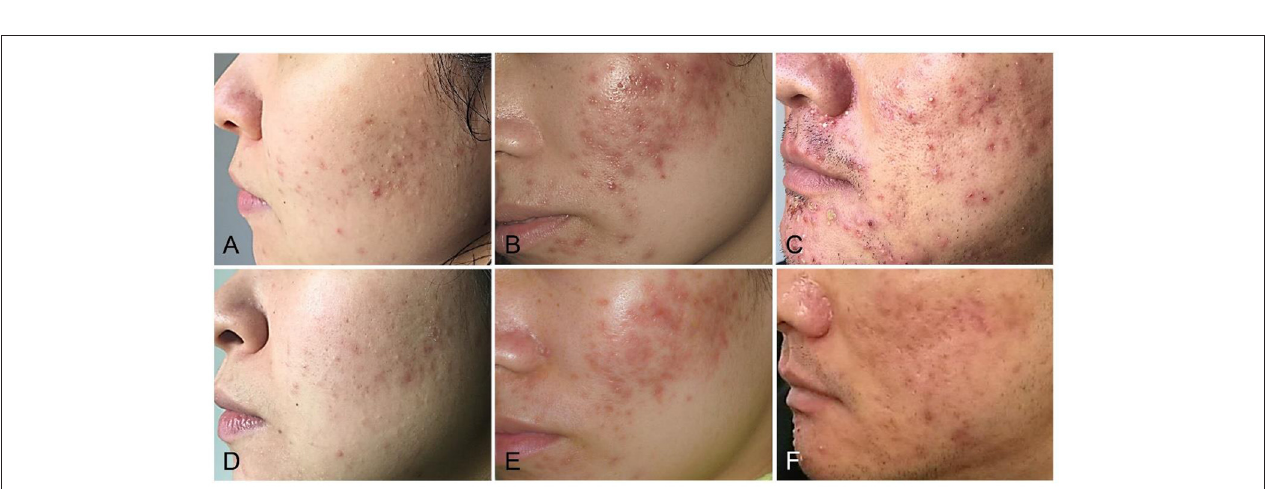
FIGURE 1 | The combined therapy reduced the number of papules and facial hyperpigmented area in the treatment group. (A) Average total number of papules/pustules before and after treatment in the treatment group and control group. (B) Average facial hyperpigmented area (%) before and after treatment in the treatment group and control group. The results are expressed as the mean ± SD. *** p < 0.001.